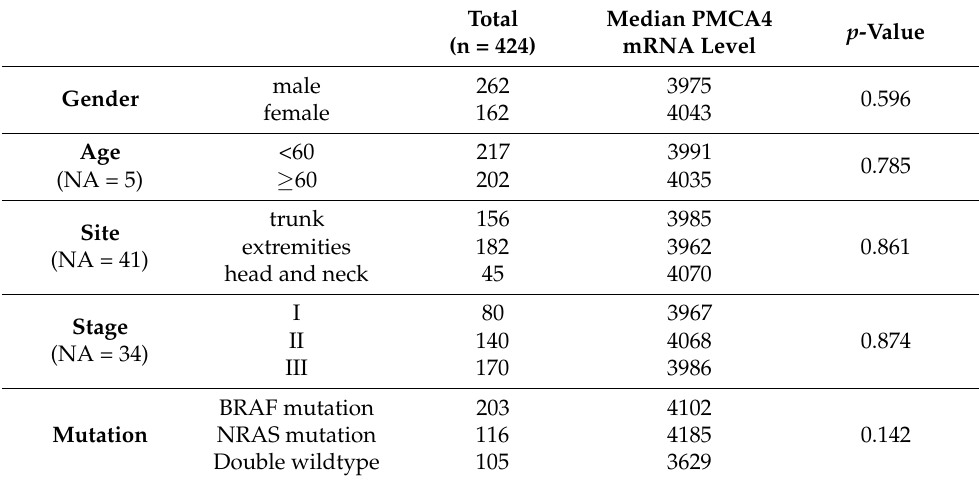
Table 2. Clinicopathological characteristics of the stage I–III cutaneous melanoma TCGA